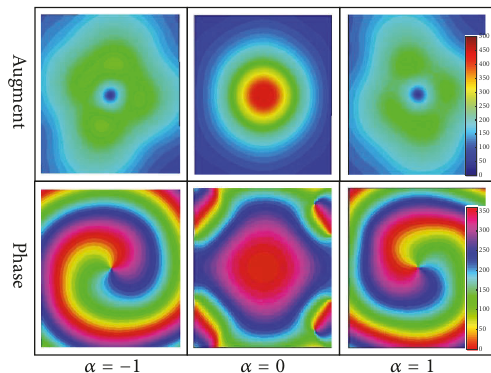
Figure 4: Augments and phases of vortex waves with different topological index of modal-1, modal 0, and modal 1 (a=18.3mm).